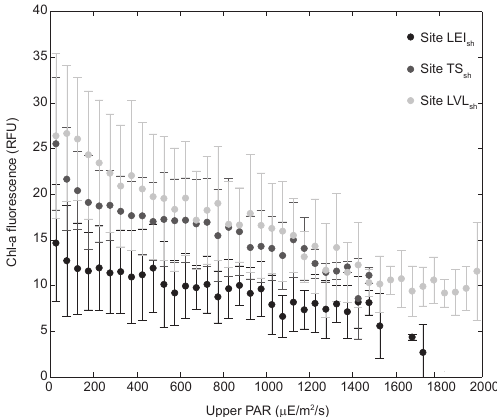
Figure 6. Relationship between salinity and fDOM at three shoal sites, with linear regressions for each population. The three sites appear distinct, suggesting variability in the nature of the fDOM